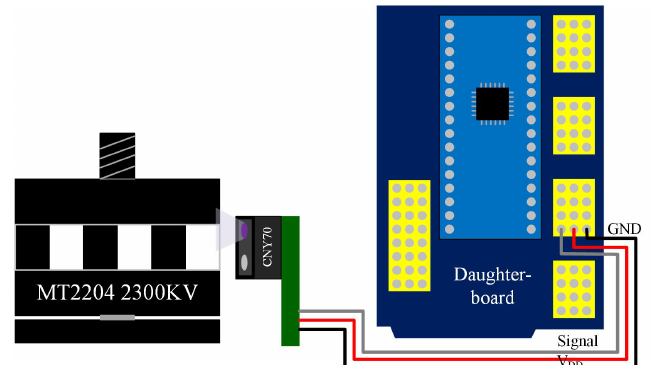
Figure 9. Propeller’s velocity sensor implementation based on a CNY70 reflective